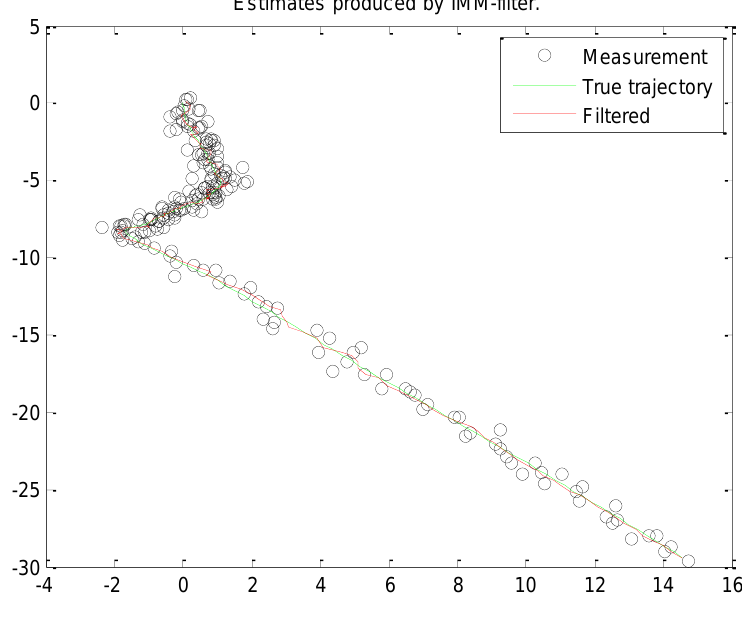
Figure 5. Results of multi-model interference filter simulation